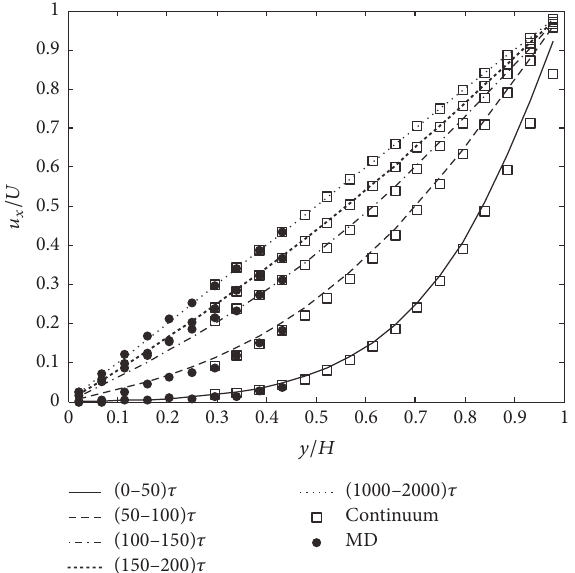
Figure 7: Velocity evolution profiles averaged over five time inter- vals compared with the analytical